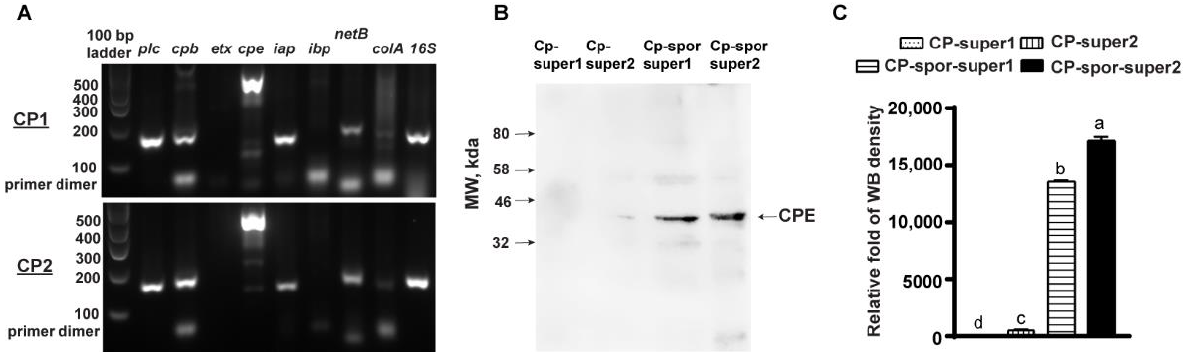
Figure 1. C. perfringens toxinotype and CPE expressed in CP1 and CP_2. ( A ). CP1 and CP_2 DNA was toxinotyped by PCR. Showed were the PCR gel image. ( B ). CP1 and CP_2 were vegetatively grown in FTG or induced sporulation in DSSM, and the soluble proteins were isolated by precipitating using ammonium sulfate method. After dissolved in pH 6.8 PBS, the soluble supernatant proteins were subjected to Western Blot analysis with anti-CPE primary Ab. ( C ). WB quantification using ImageJ. The Western Blot image of CPE expression is shown. Different letters mean significant.